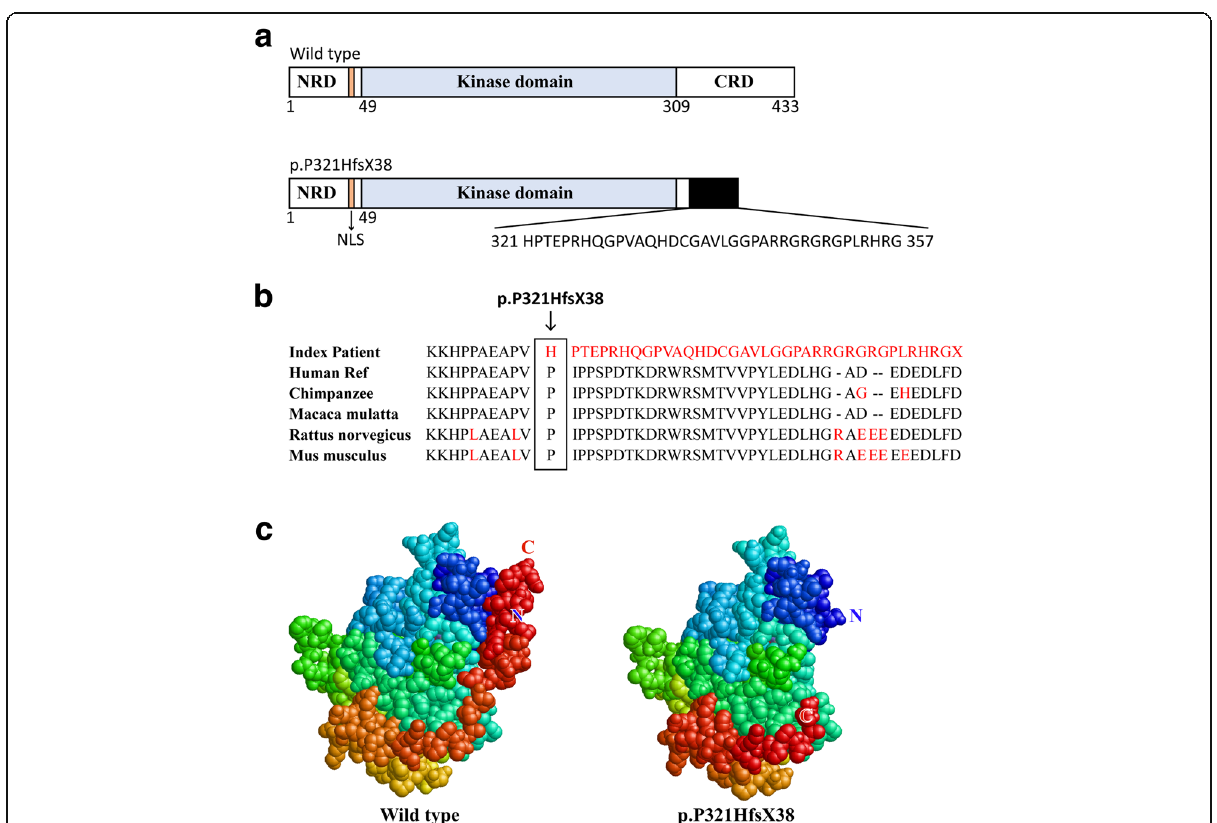
Fig. 2 The mutant protein structure. a Schematics of the secondary structure or functional domains of the STK11 protein. NLS, Nuclear localization signal, NRD or CRD, N- or C-terminal regulatory domain. b Evolutionary conservation of amino acid residues altered by c.962_963delCC (p.P321HfsX38) across different species. c The mutant proteins (p.P321HfsX38) were predicted to result in partial loss of the C-terminal domain of the a-helix by Swiss-Model online software compared to the wild